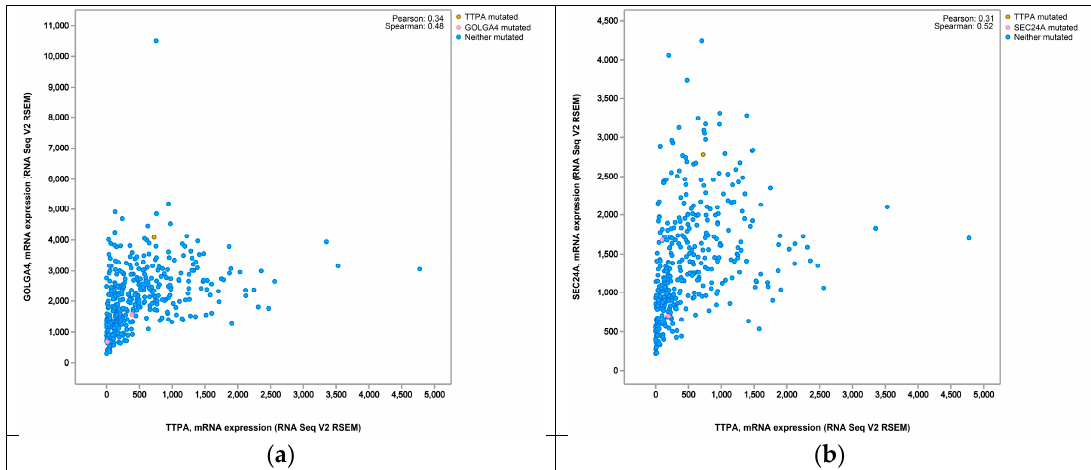
Figure 3. mRNA co-expression in Liver Hepatocellular Carcinoma : ( a ) Tocopherol Transfer Protein A (TTPA) vs. Golgin subfamily a 4 (GOLGA4); ( b ) TTPA vs. Sec24 homolog A (SEC24 A).